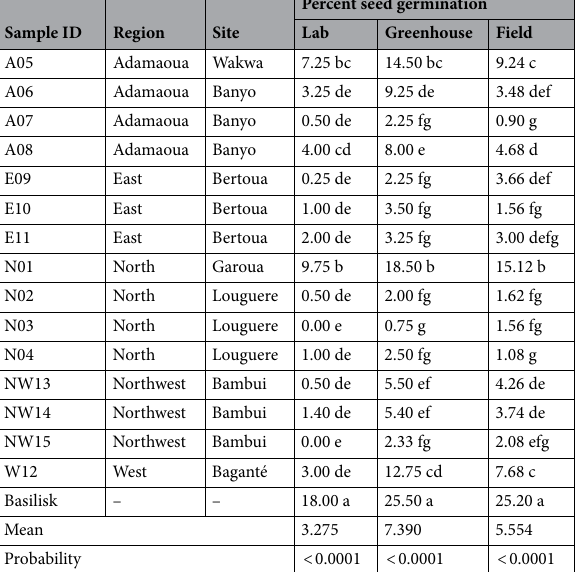
Table 2. Germination of Urochloa grass seed samples from different regions of Cameroon at laboratory, greenhouse, and field conditions. Values with different letter(s) within a column are statistically difference.